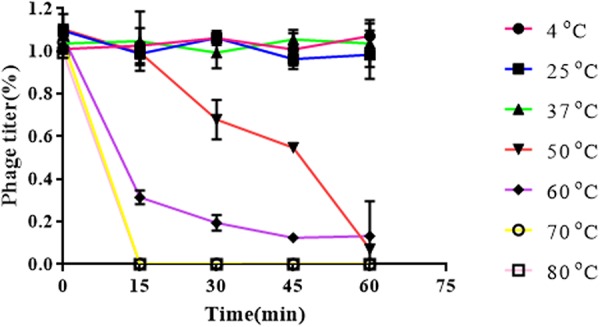
Thermal stability of phage vB_EaeM_φEap-3. Each data point represents the mean of three independent experiments. Results were expressed as PFU/mL.